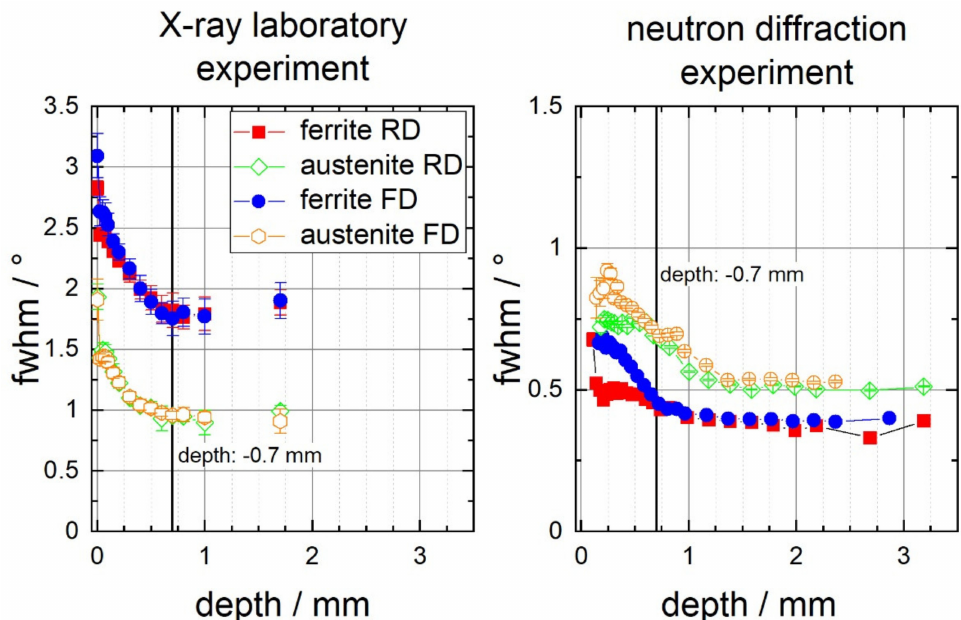
Figure 6. FWHM values of the ferrite and austenite interference lines of deep rolled duplex steel 1.4462 in the rolling direction (RD) and the feed direction (FD) determined by means of X-ray diffraction ( left ) and neutron diffraction ( right ). The data are based on the X-ray results.